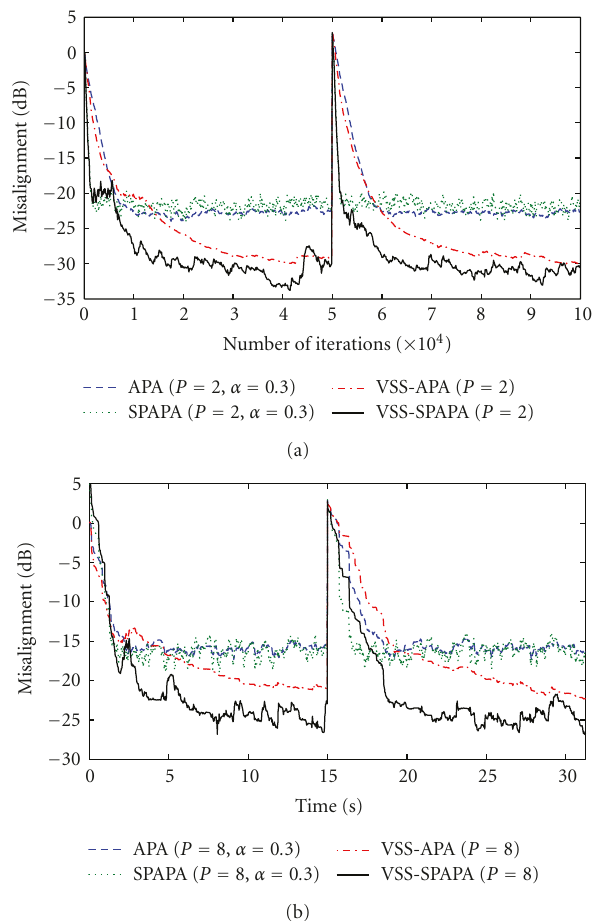
Figure 7: Misalignment of the algorithms with adaptive estimate of ( t ). The unknown impulse response changes at 5 × 10 4 iteration. σ 2 v (a) With highly colored input generated by G ( z ). P = 2. (b) With speech input signal, P =